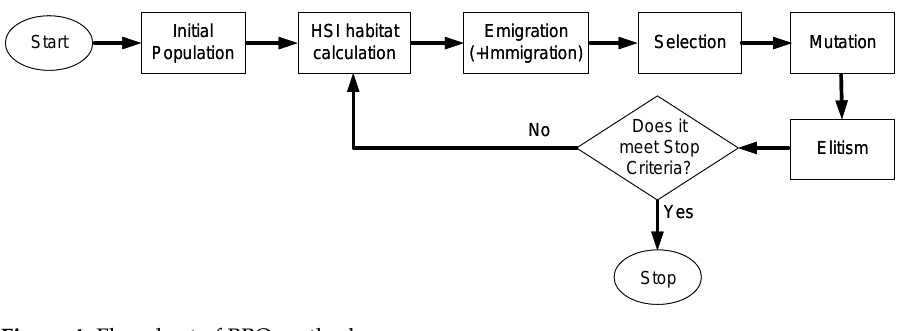
Figure 4. Flowchart of BBO method.